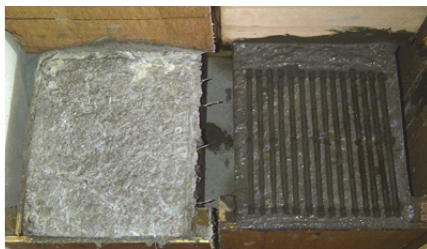
Figure 1: Difference of substrate surface conditions between being as-placed and grooved with 6 mm of roughness